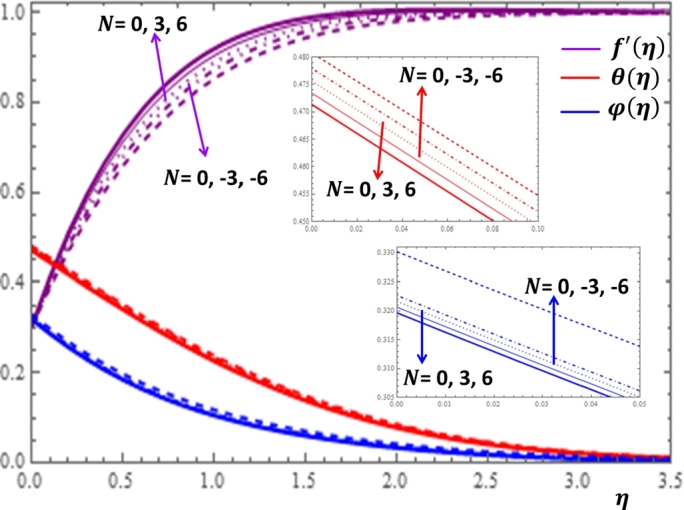
Impacts of buoyancy ratio parameter N on f′(η), θ(η) and φ(η).